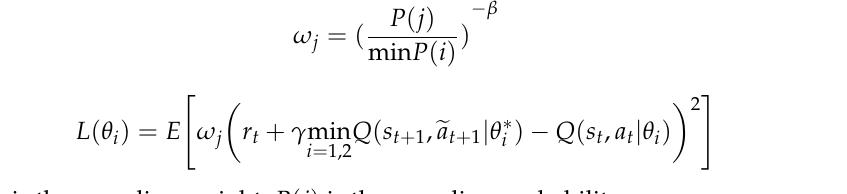
where ω j is the sampling weight; P ( j ) is the sampling